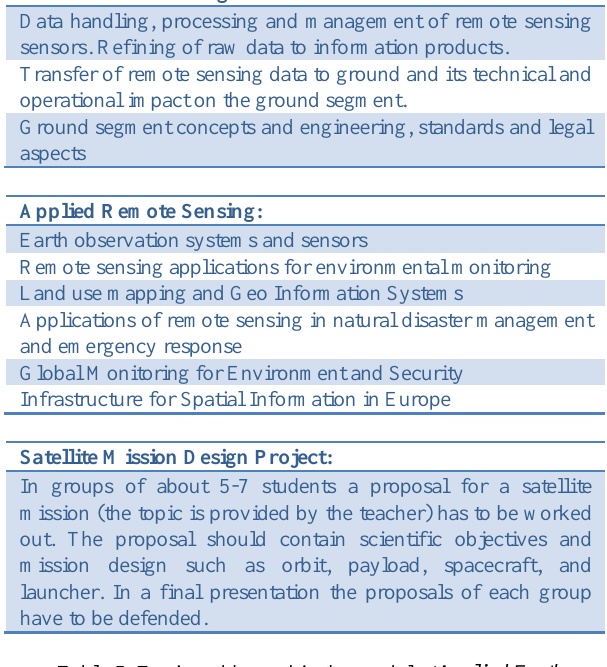
Table 5. Topics addressed in the module ‘ Applied Earth Observation and Mission Engineering ’ (2.